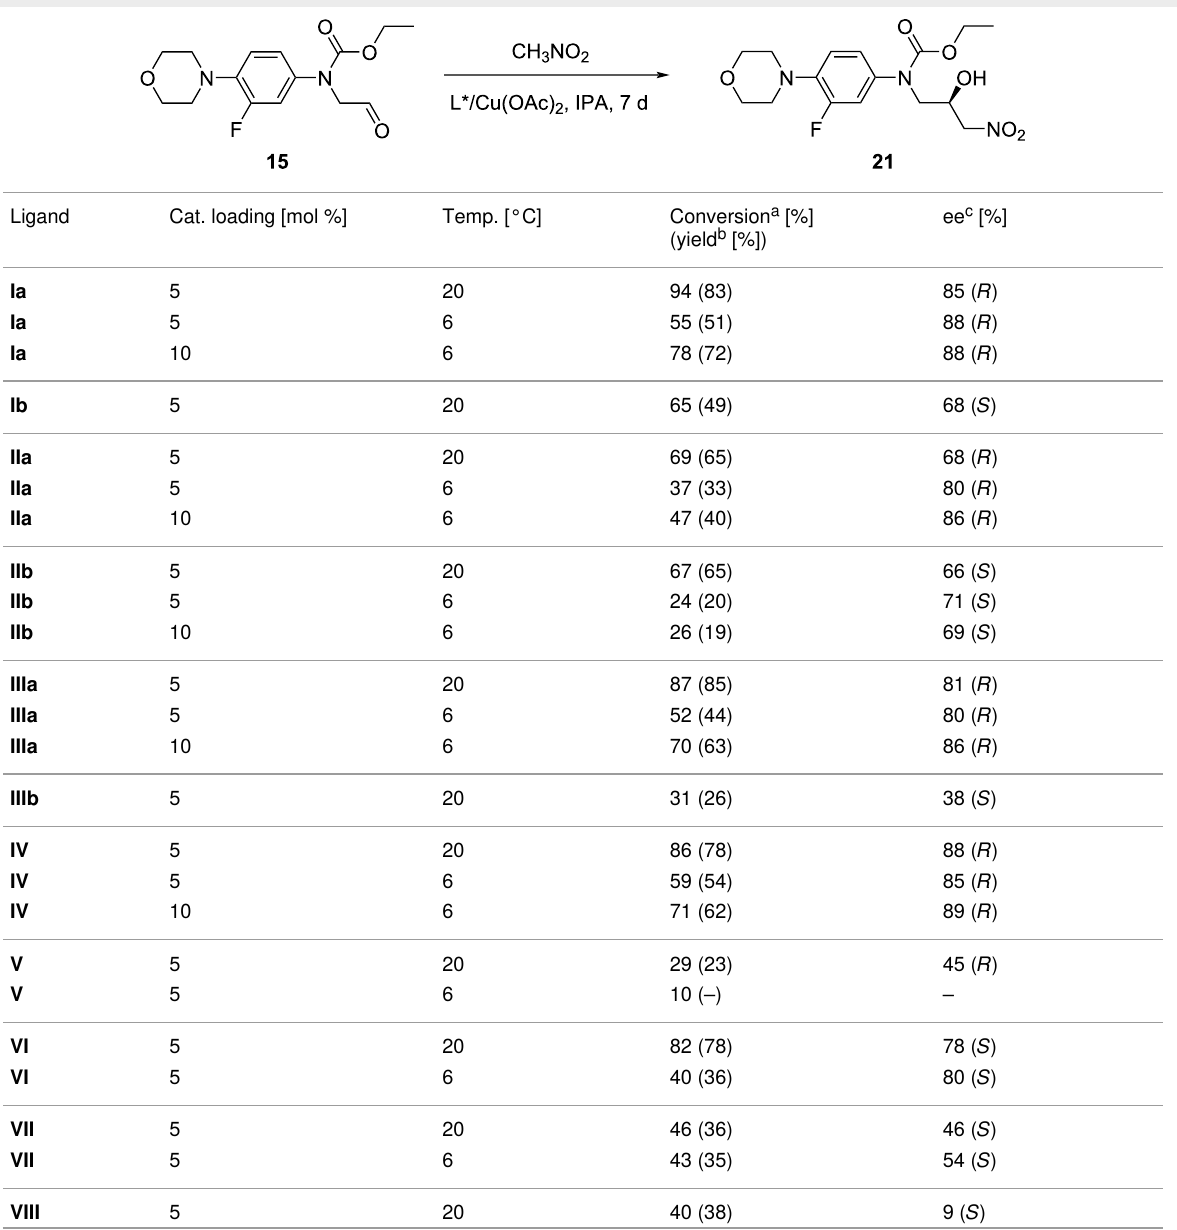
Table 1: Asymmetric Henry reactions of aldehyde 15 with nitromethane under various conditions.